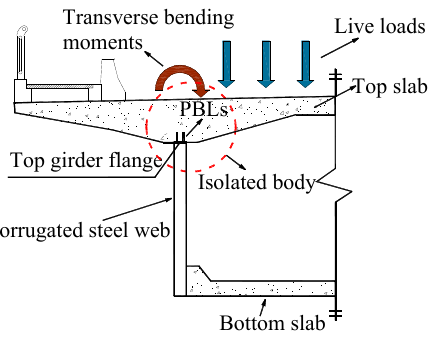
Figure 1. Typical cross-section of the prototype composite beam.